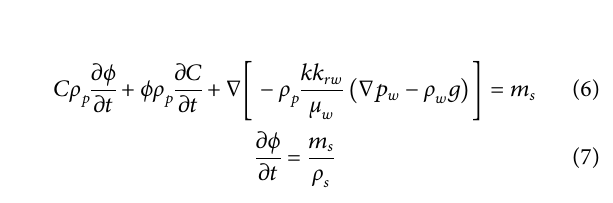
FIGURE 3 | Evolution curves for the mass percentage of migrated fi ne particles.